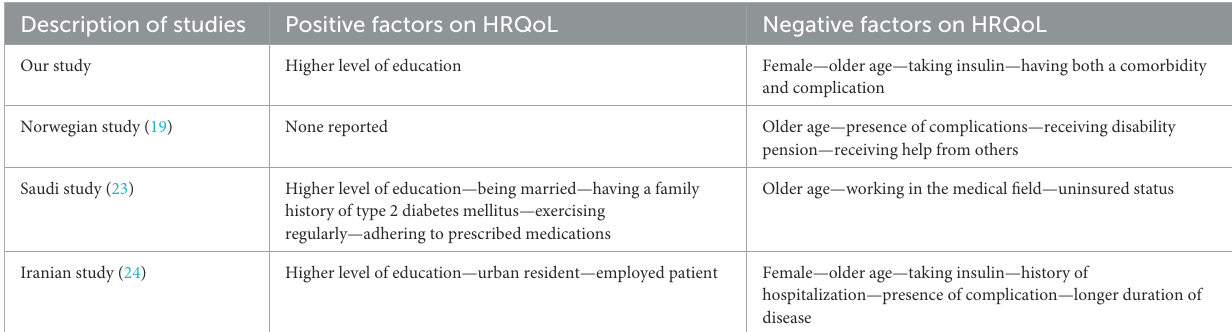
TABLE 7 Factors affecting HRQoL; summary from our study and different